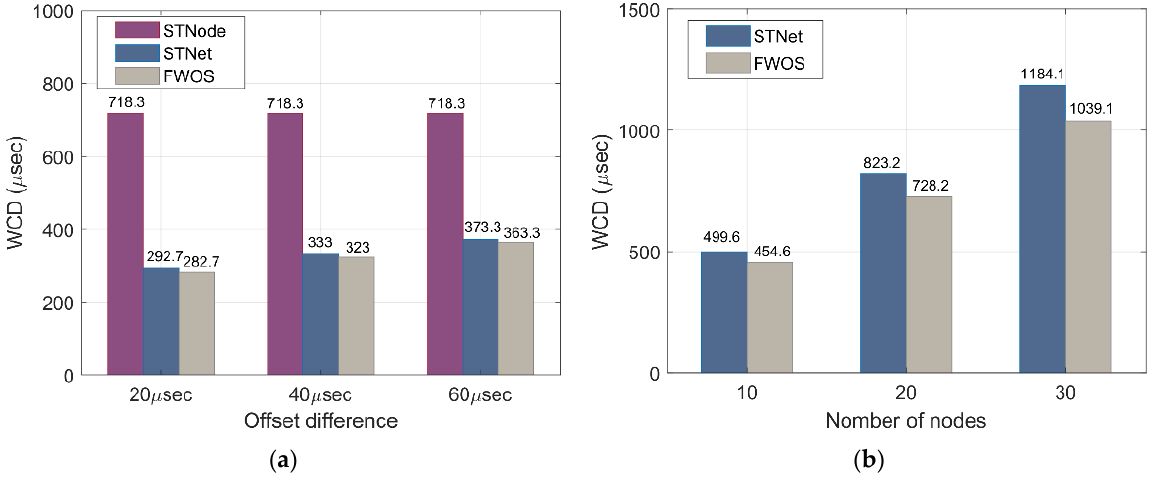
Figure 17. Comparison between the proposed flexible window-overlapping scheduling (FWOS) algorithm and related works: ( a ) FWOS, STNode ([11]), and STNet ([13]) under different relationships between offsets for same-priority windows among three nodes. ( b ) FWOS and STNet ([13]) with constant relationships between offsets in connections with 10, 20, and 30 hops.